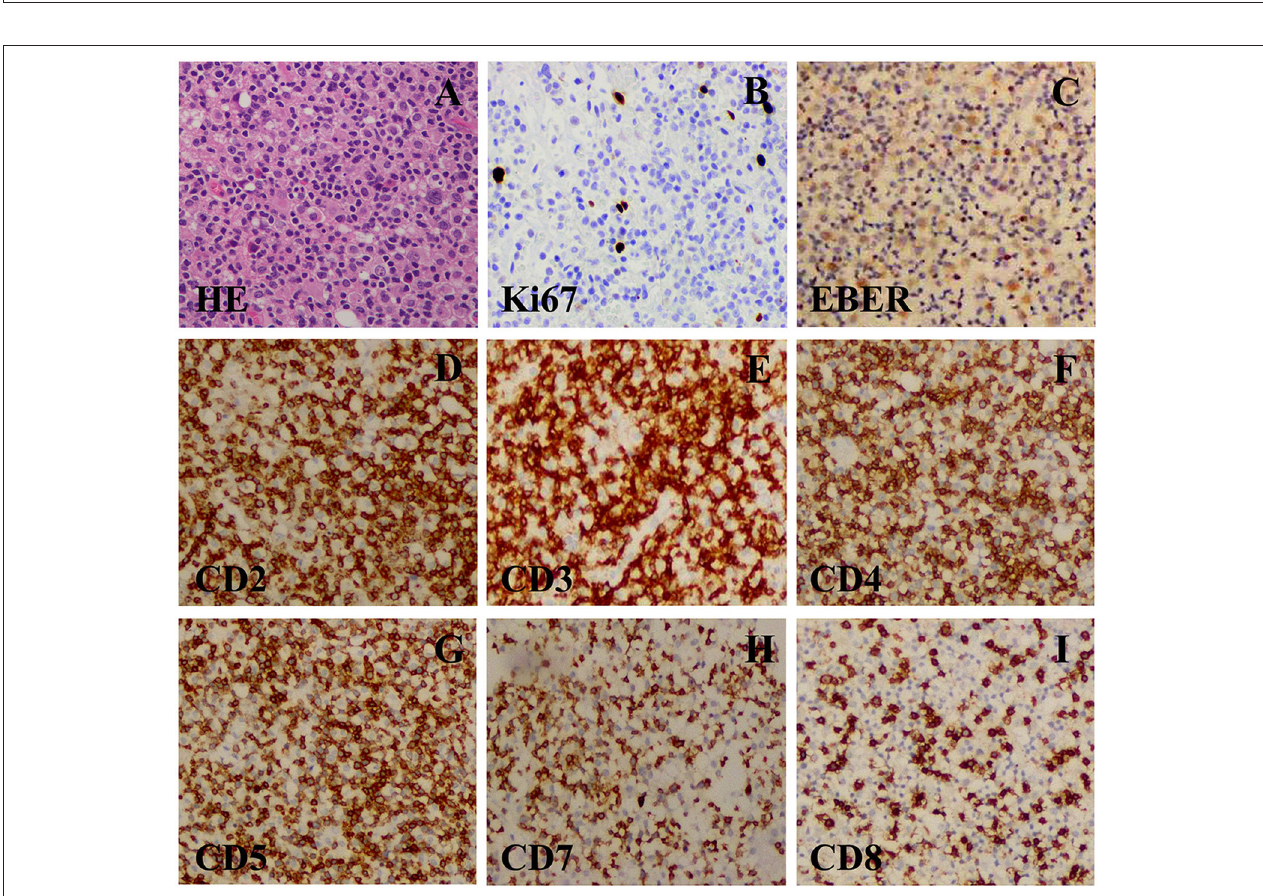
FIGURE 2 | (A) A resection specimen showed a lot of densely small lymphoid cells diffuse infiltrating. The small lymphoid cells were predominantly composed of polymorphous cells with hyperchromatic nuclei with sporadic mitoses (original magnification × 400). (B–G) Immunohistochemical staining (original magnification × 400). (B) CD3( + ) T-cell. (C) CD5( + ) B-cell. (D) CD7( + ) B-cell. (E) CD8( + ) B-cell. (F) CD20(–) B-cell. (G) CD56(–) NK-cell. (H) Ki67( + ). (I) Ki67( + ) (about 40%).